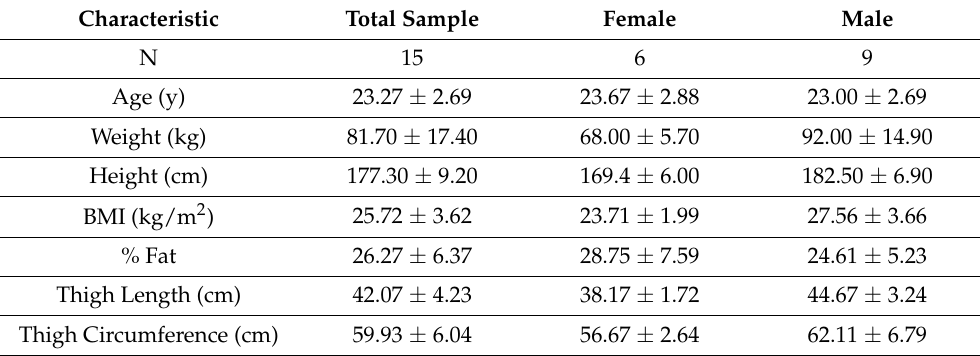
Table 1. Participant characteristics (M ±